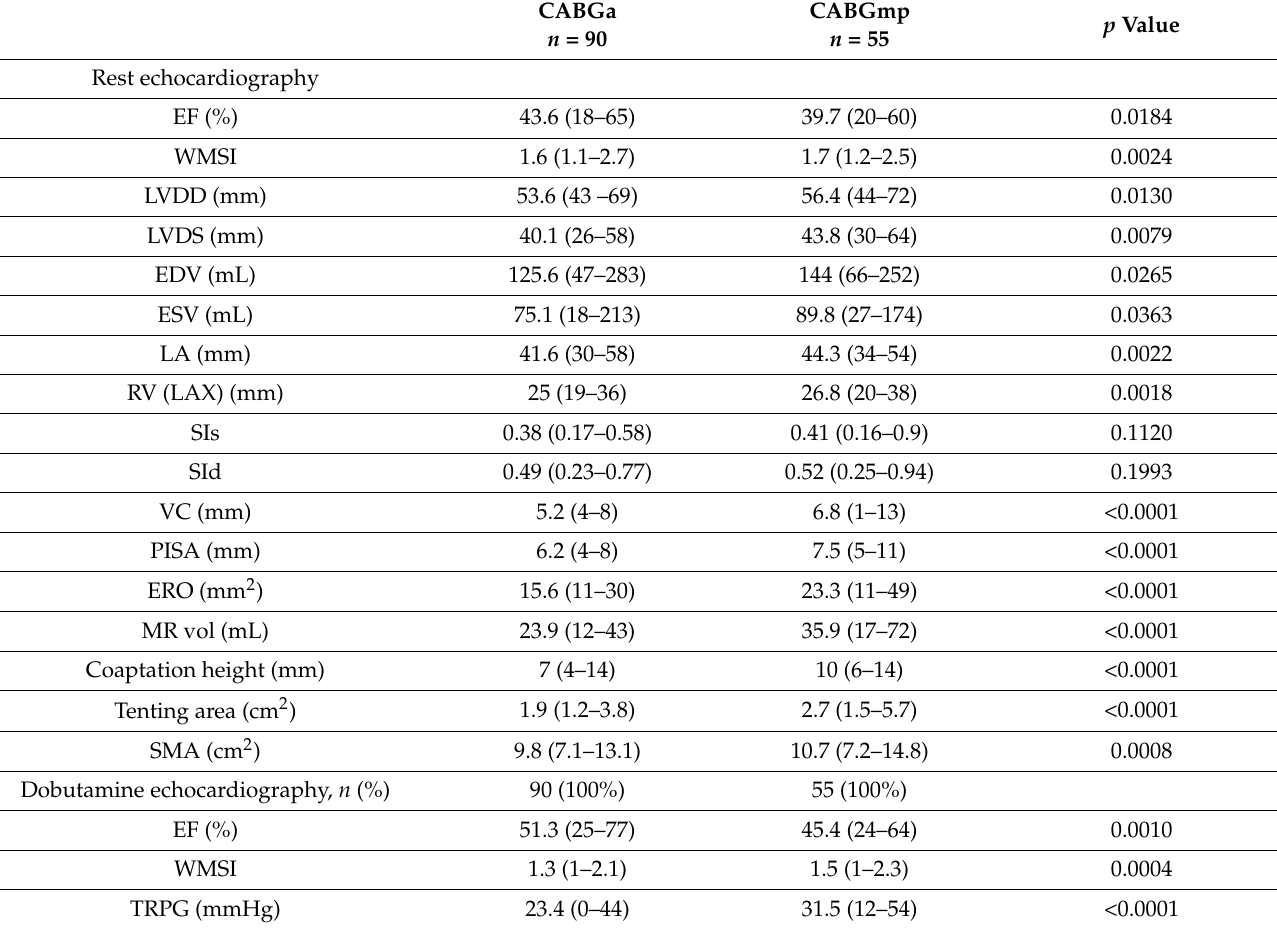
Table 3. Baseline echocardiographic parameters in patients with IMR treated by CABGa or